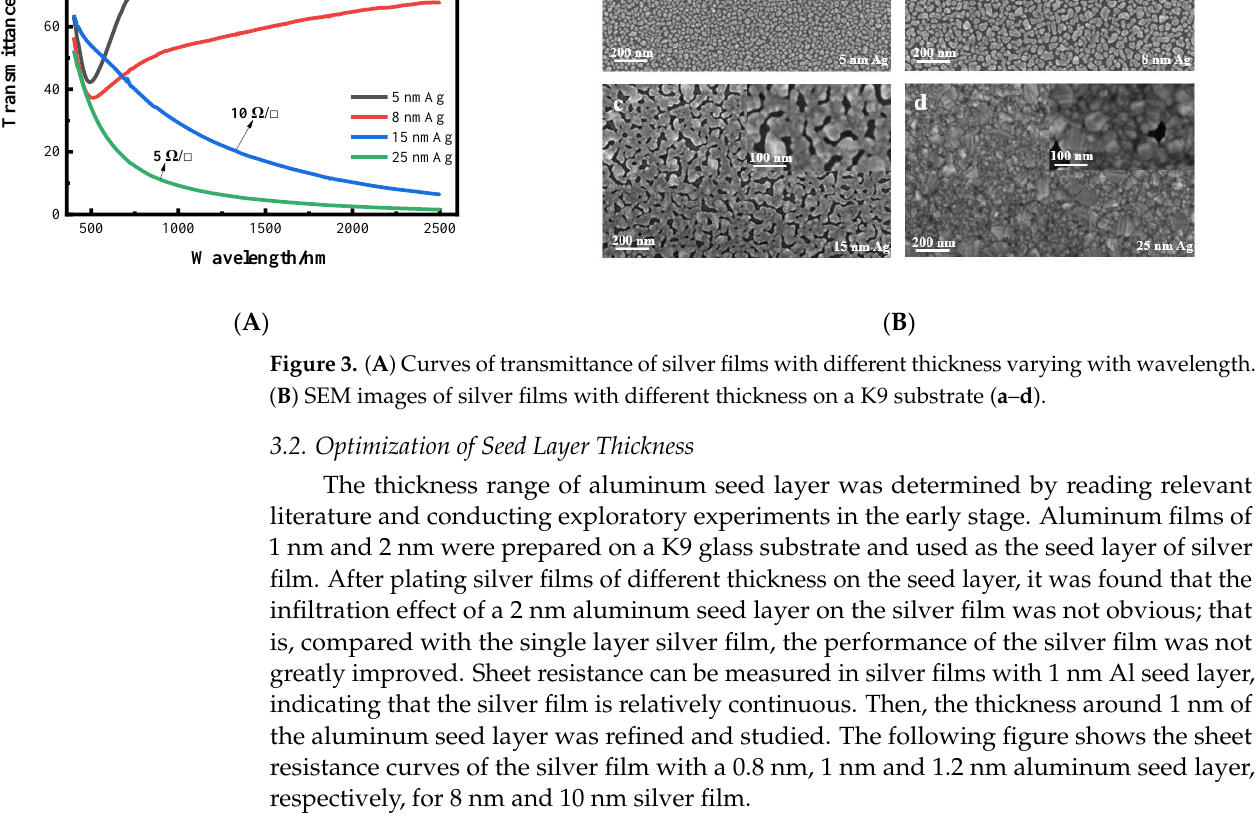
Figure 3. ( A ) Curves of transmittance of silver films with different thickness varying with wave- length.; ( B ) SEM images of silver films with different thickness on a K9 substrate ( a – d